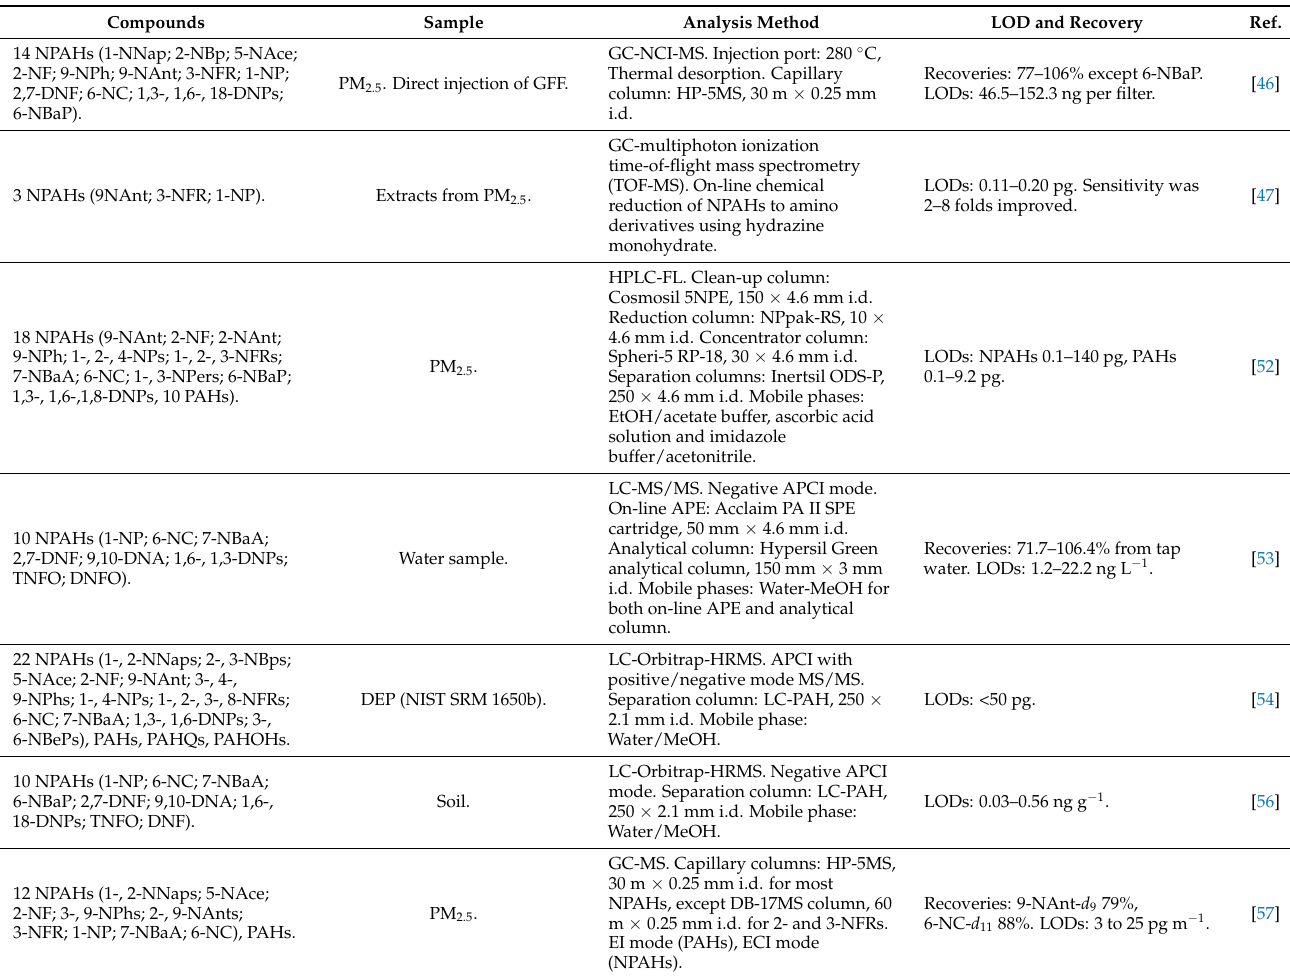
Table 2. Typical analysis methods for